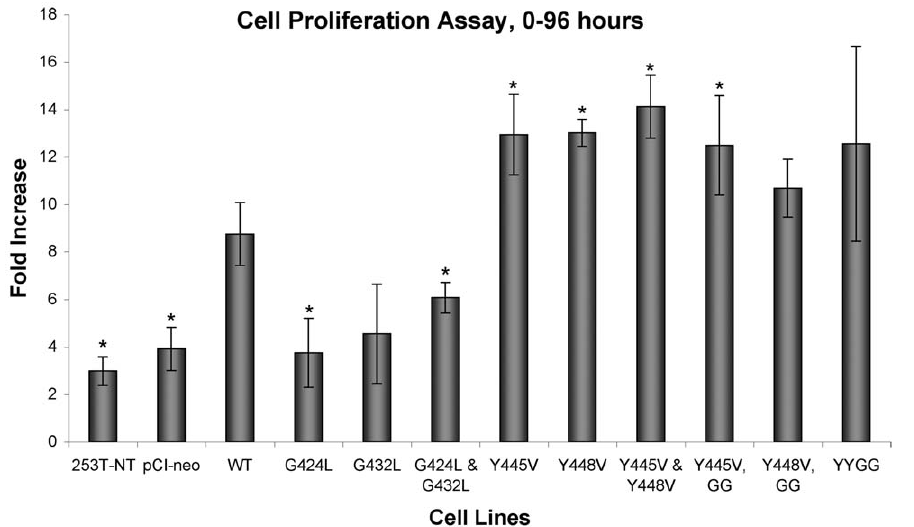
Figure 7. Rates of Cell Proliferation of CEACAM1-4S Transfectants. The bars show the fold-increase in cells at 96 hours after plating. The columns marked with an asterisk were sublines showing an increase in cell number between 0 and 96 hours that according to P values (p , 0.05), was significantly higher or lower than 253T-NT cells transfected with wild type (WT) CEACAM1-4S. In general, the number of 253T-NT cells expressing G to L mutants increased at a slower rate and Y to V mutants at a higher rate than cells expressing wild type CEACAM1-4S. Results shown represent four separate assays.